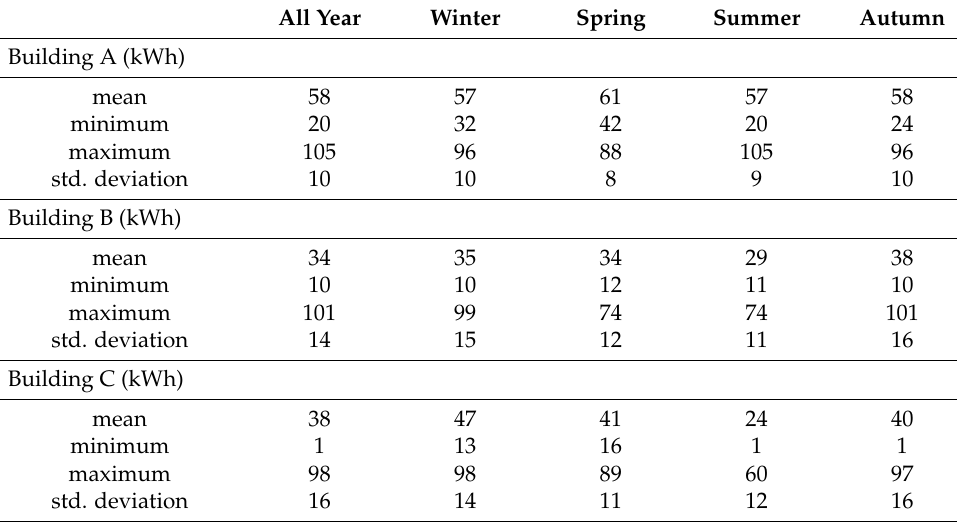
Table 6. Electricity demand (kWh) of buildings A, B, and C.